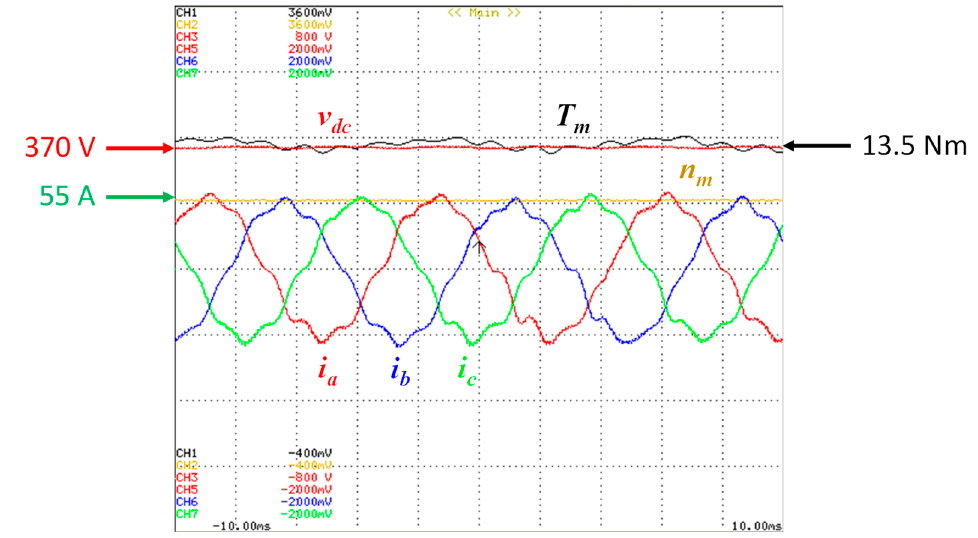
Figure 15. Experimental results of the traction system operating at a constant speed (2000 rpm) with a 12 Nm load: the torque ( T m ) and speed ( n m ) of the SRPM machine; dc-link voltage ( v dc ); stator windings’ currents ( i a , i b , i c ).